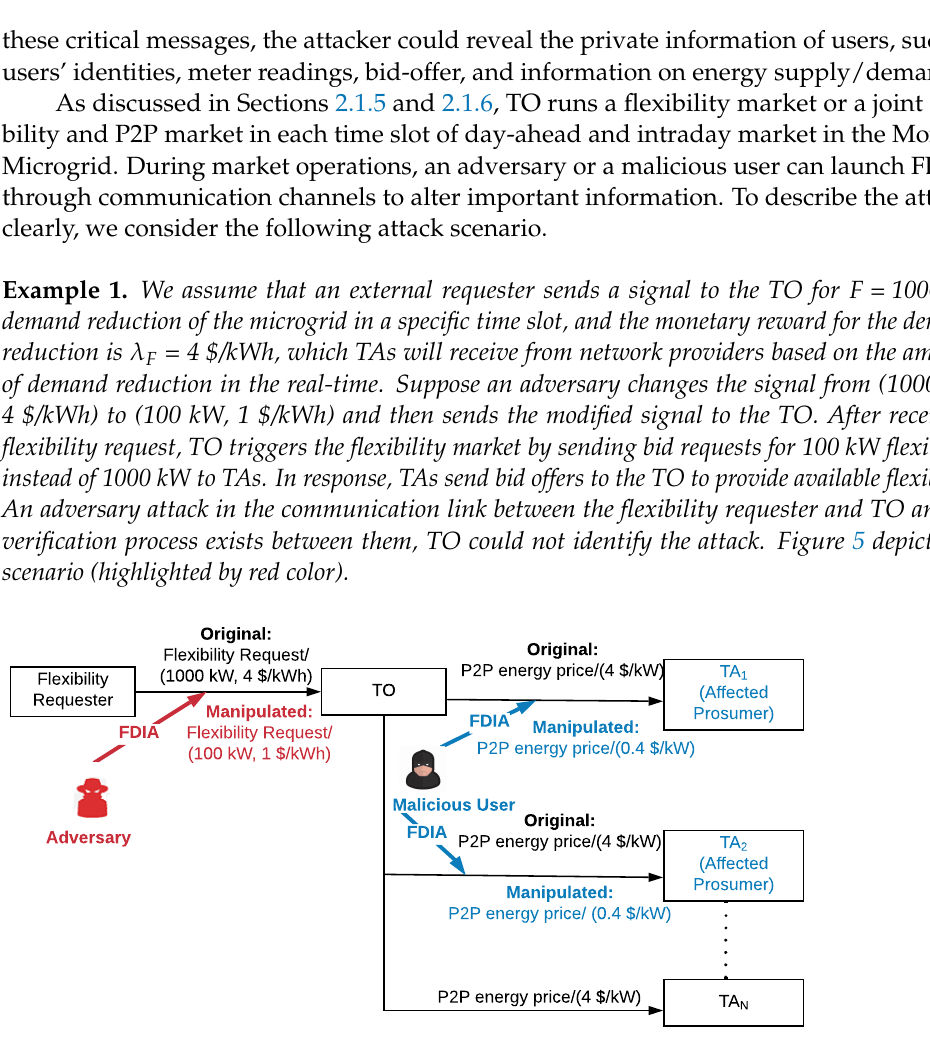
Figure 5. FDIAs through communication channel by an adversary and a malicious user highlighted by red and blue color,